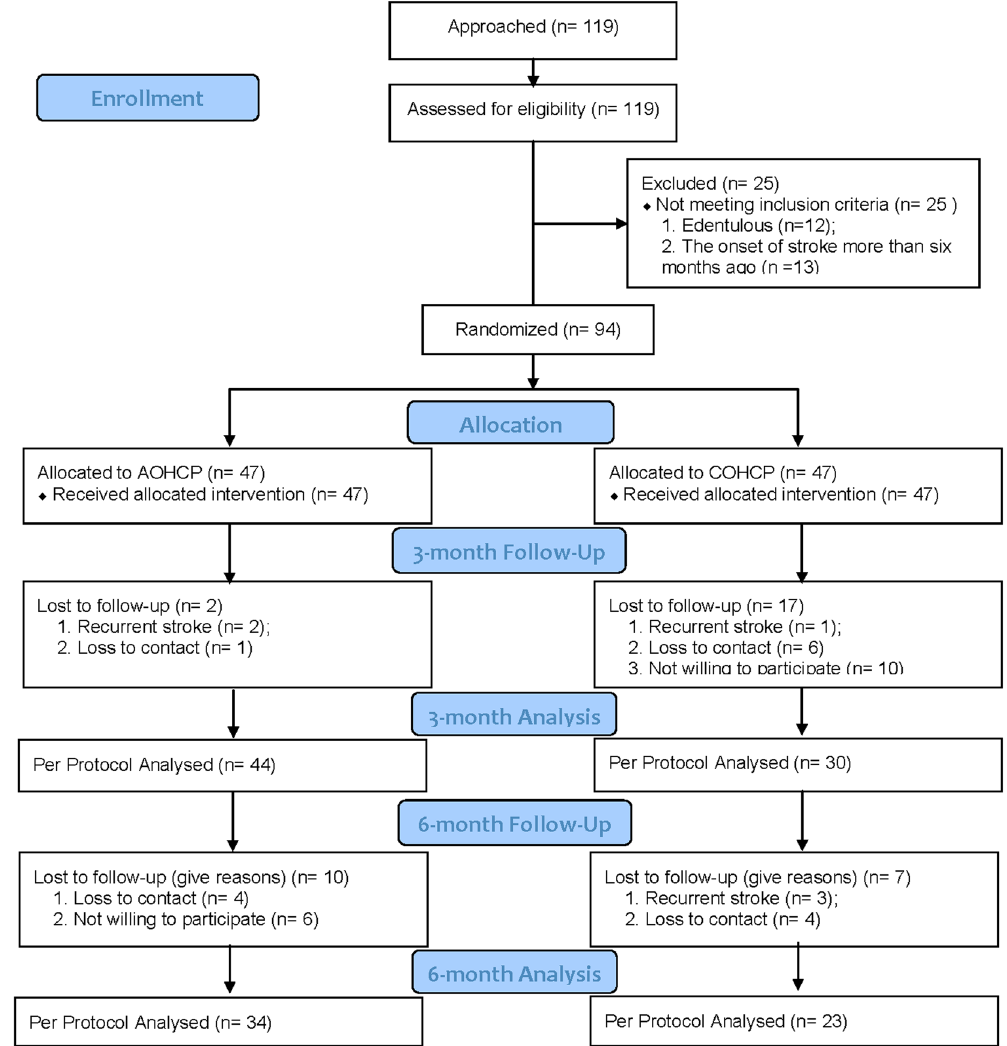
Figure 1. Flow diagram of numbers of patients undergoing stroke rehabilitation in different stages of the